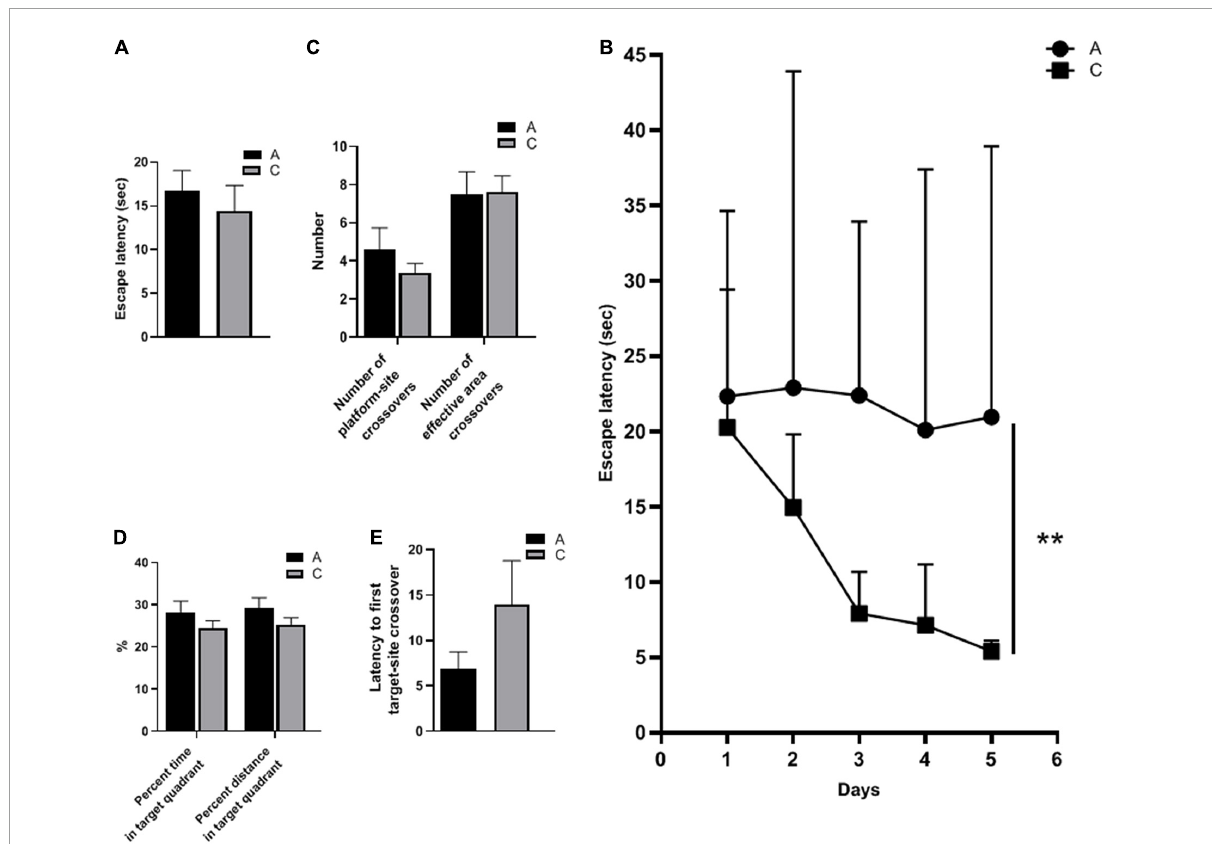
FIGURE1 Spatial learning and memory abilities of APP/PS1 and wild-type mice in the MWM test. Escape latency in cued learning (A) and place navigation test (mean ± standard deviation) (B) , the number of platform-site crossovers and effective area crossovers (C) , percent time and percent distance in the target quadrant (D) , and latency to first target-site crossover (E) in the spatial probe test. Groups: A, APP/PS1 double-transgenic mice; C, wild-type control group of C57BL/6J mice; n = 8/group. ** P <